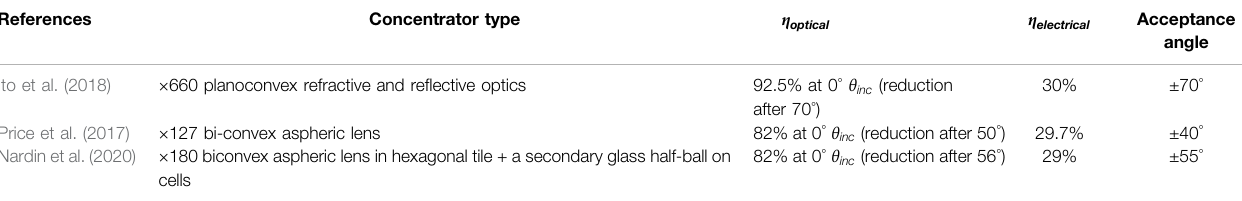
TABLE 1 | Performance benchmark of module-scale